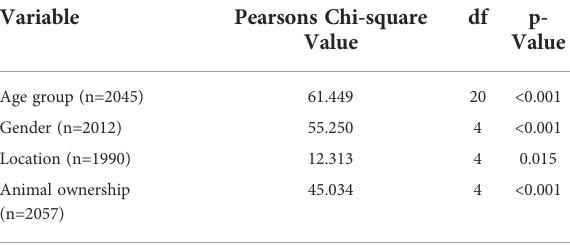
TABLE 2 Association between demographic variables and opinion towards prosecution rates.